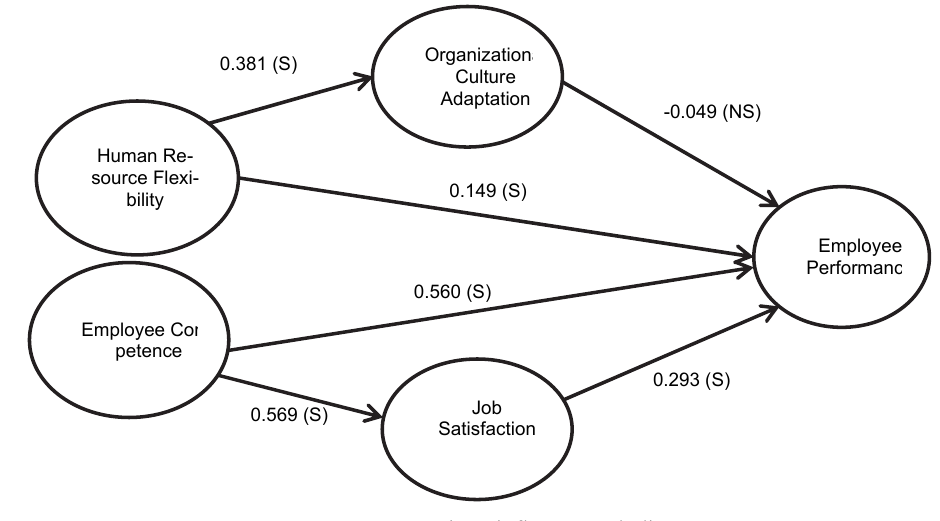
Fig. 1. Direct influence path